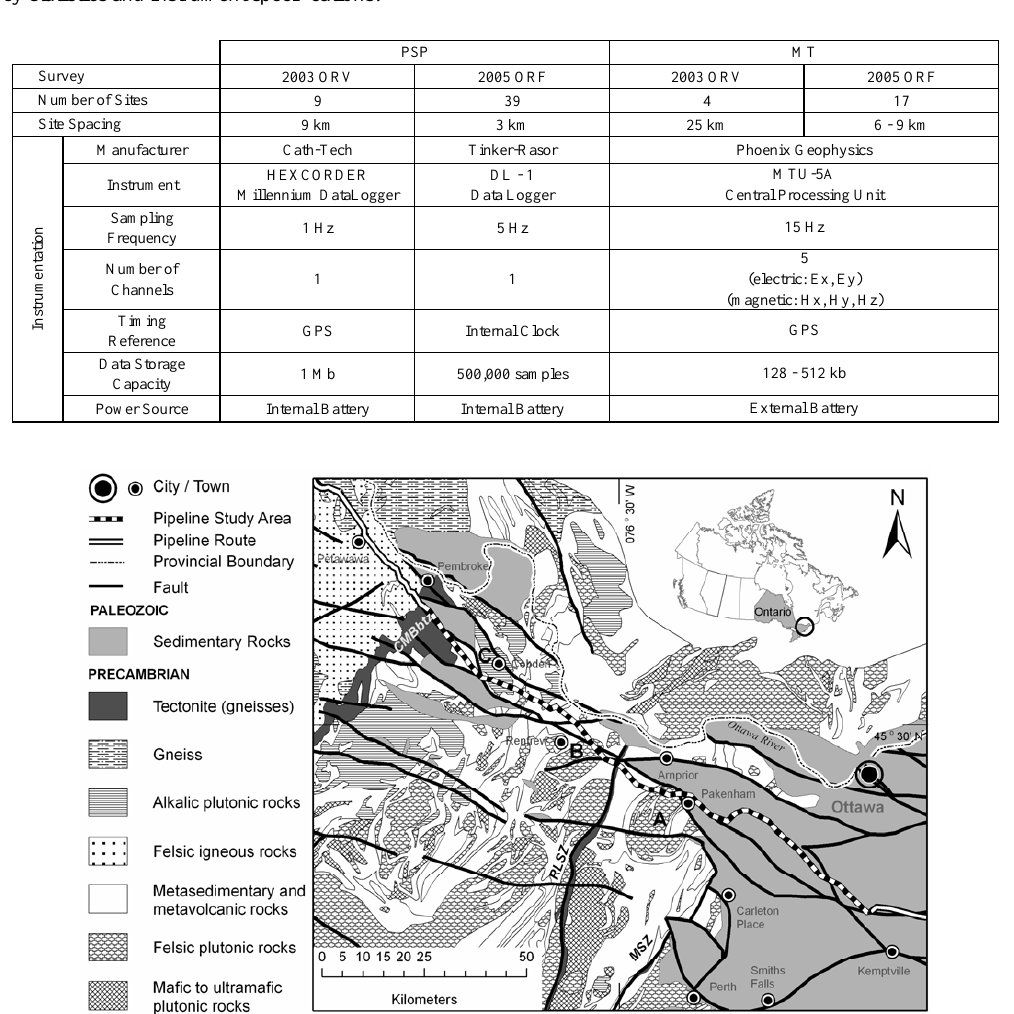
Fig. 2. Bedrock geology map of the Ottawa River valley and region, crossed by the pipeline. Tectonic units: CMBbtz, Central Metasedimen- Figure 2. tary Belt boundary thrust zone; RLSZ, Robertson Lake Shear Zone; MSZ, Maberly Shear Zone. Intrusives: A, Pakenham Dome; B, Hurds Lake; C, Bonnechere Ridge (modified from Ontario Geological Survey,